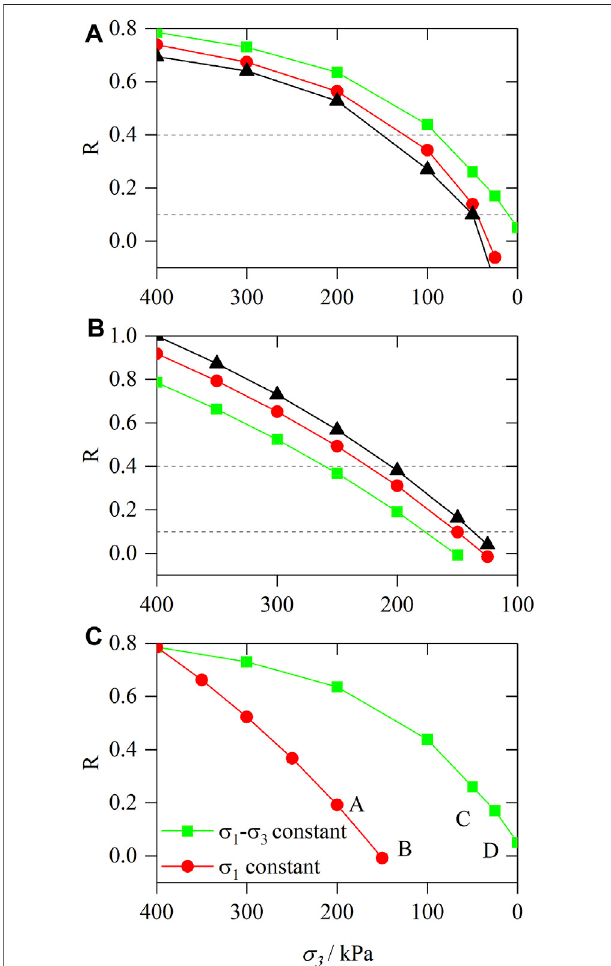
FIGURE 8 | (A) Comparison of R under different deviator stress. (B) Comparison of R under different principal stress. (C) Comparison of R in different stress